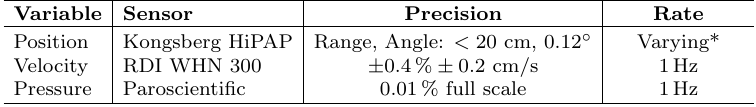
Table 3: Primary navigation aiding